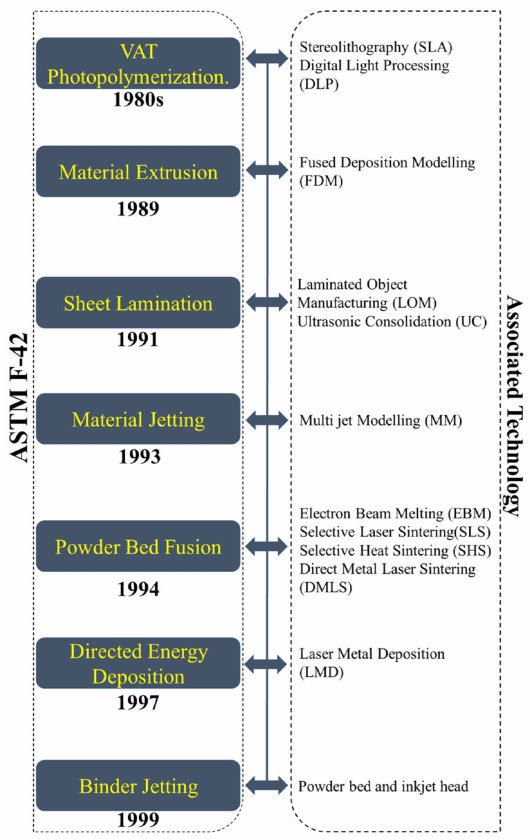
Figure 6. Classification of additive manufacturing on ASTM F-42 and its associated